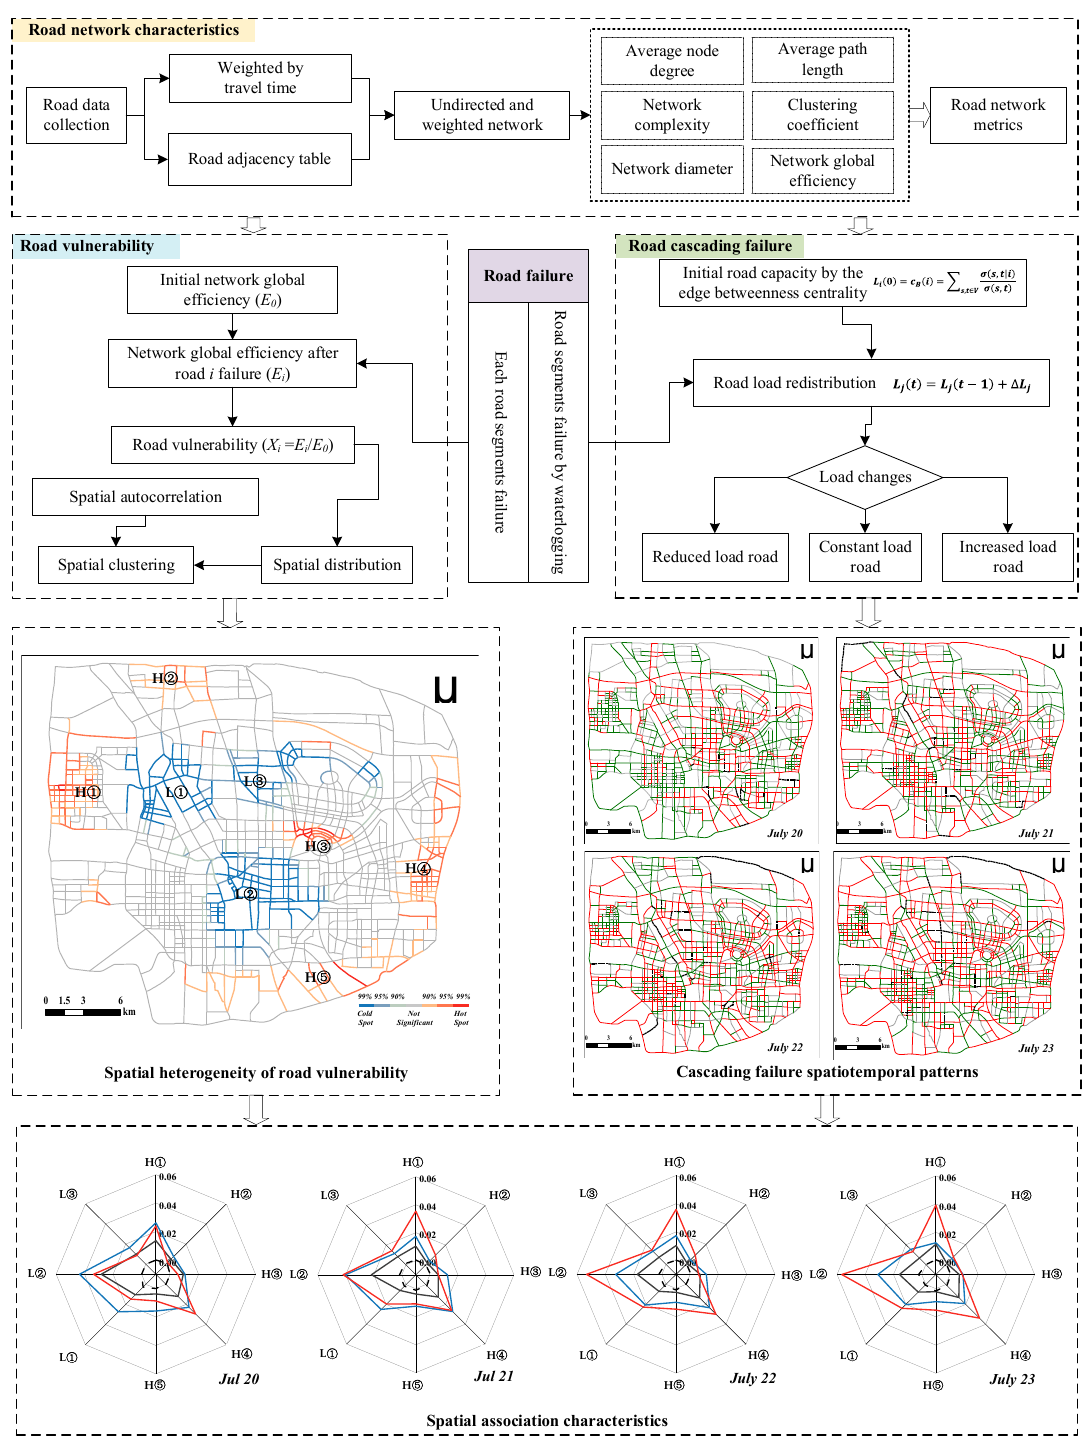
Figure 3. The methodology